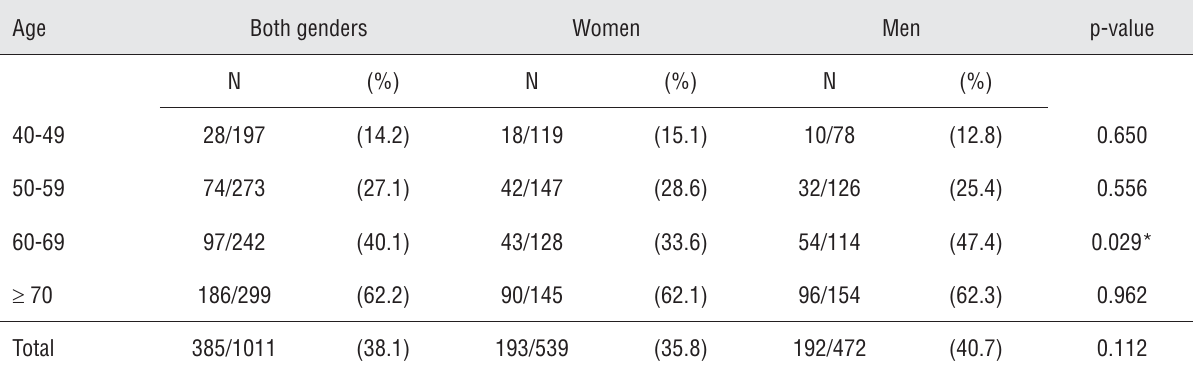
Table 1 - Prevalence of nocturia (  2 episodes/night) by age and gender.